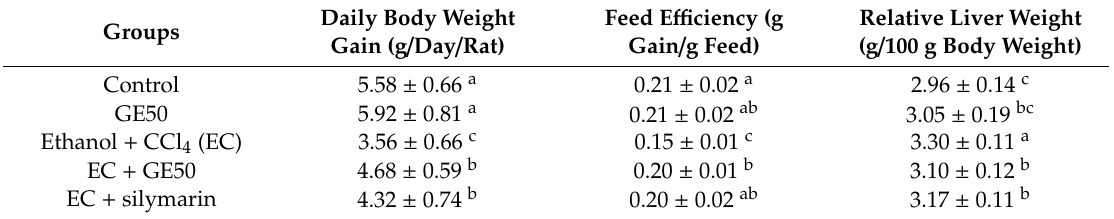
Table 1. E ff ects of oral administration of 50% ethanolic Graptopetalum paraguayense E. Walther (GE50) over six consecutive weeks on body weight gain, feed e ffi ciency, and relative liver weight in rats treated with ethanol + carbon tetrachloride (CCl 4 ).